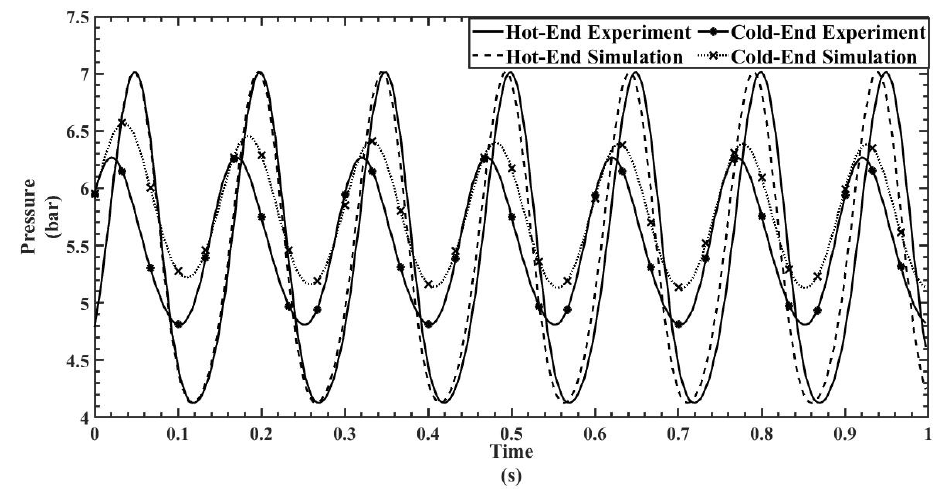
Figure 16. Hot- and cold-section pressure characteristics of a 200 mesh regenerator at 400 RPM.